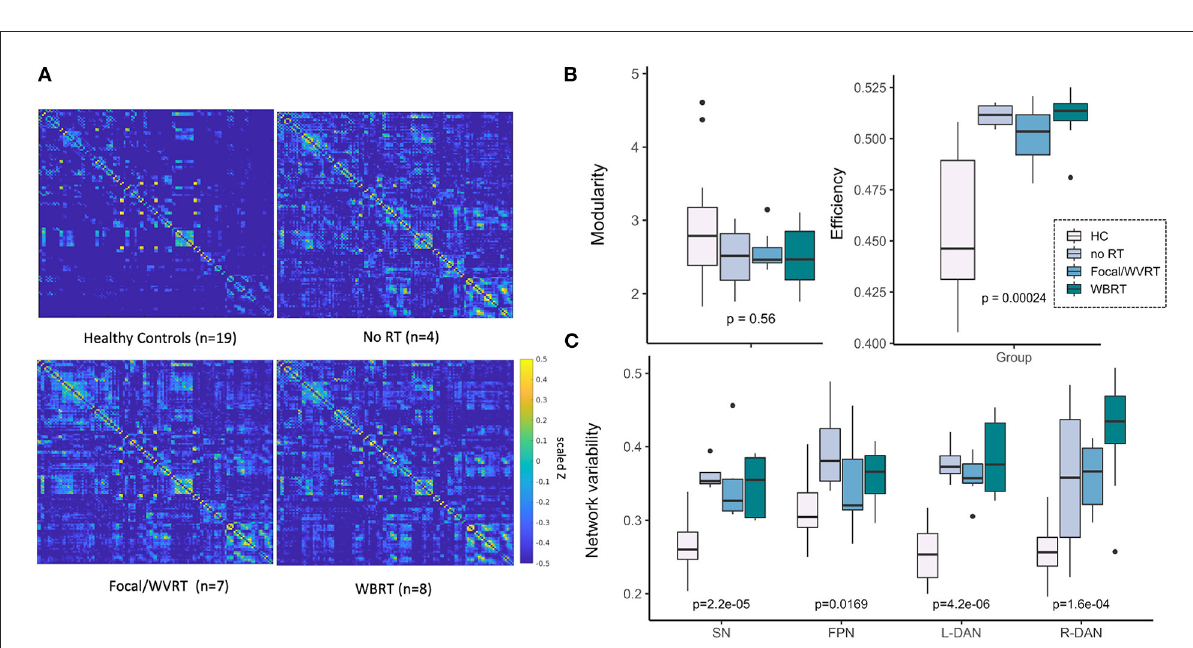
FIGURE4 MR metrics can distinguish healthy controls and patient subgroups. Scaled and Fisher transformed functional connectivity (FC) matrices reveal notable group differences in global connectivity (A) . MR metrics derived from FC matrices and ICA brain networks show significant group trends related to group exposure to radiation therapy (RT) and/or the degree of RT treatment aggressiveness (B, C) . HC, healthy controls; no RT, non-irradiated patients; WVRT, whole-ventricular focal RT; Focal, focal RT to the supratentorial brain; WBRT, whole-brain RT.